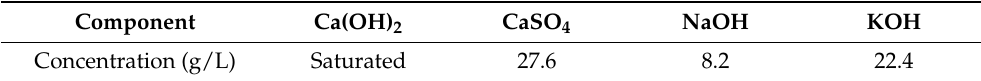
Table 3. The chemical composition of the pore